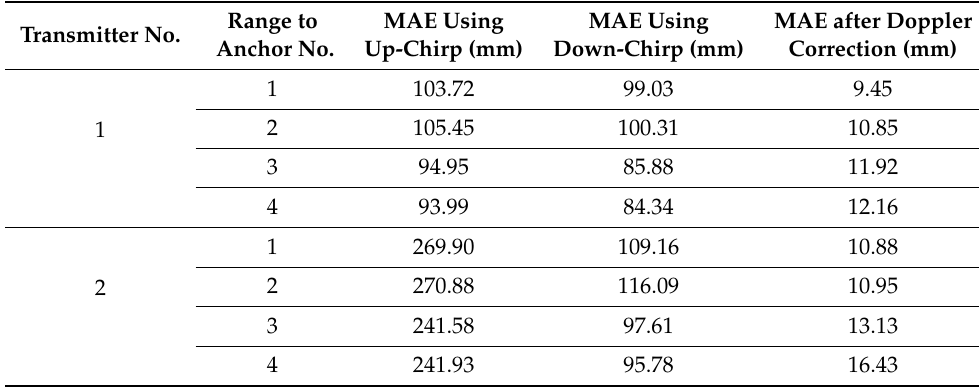
Table 1. Comparison of MAE for range measurement with and without Doppler correction. Range to MAE Using MAE Using MAE after Doppler Transmitter No. Anchor No.